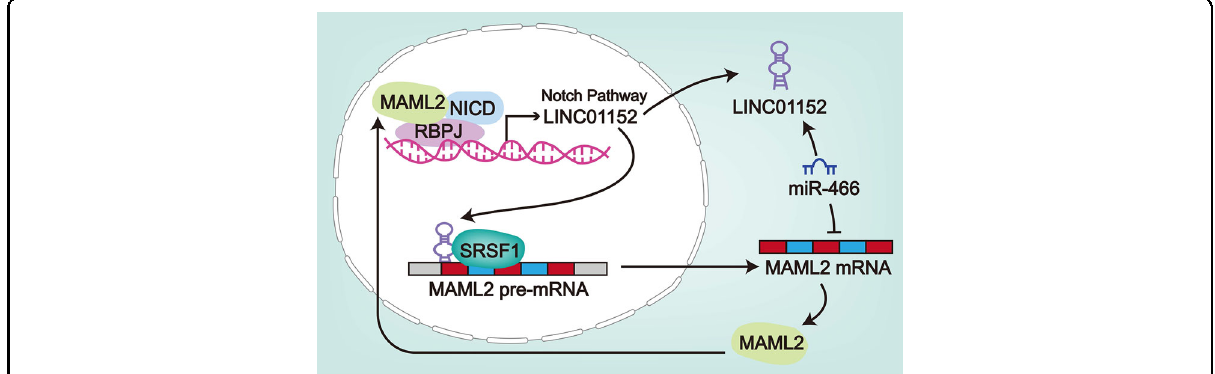
Fig. 8 A positive feedback loop between LINC01152 and NOTCH pathway promotes GBM cell growth. The schematic diagram describing the molecular mechanism of LINC01152 in GBM